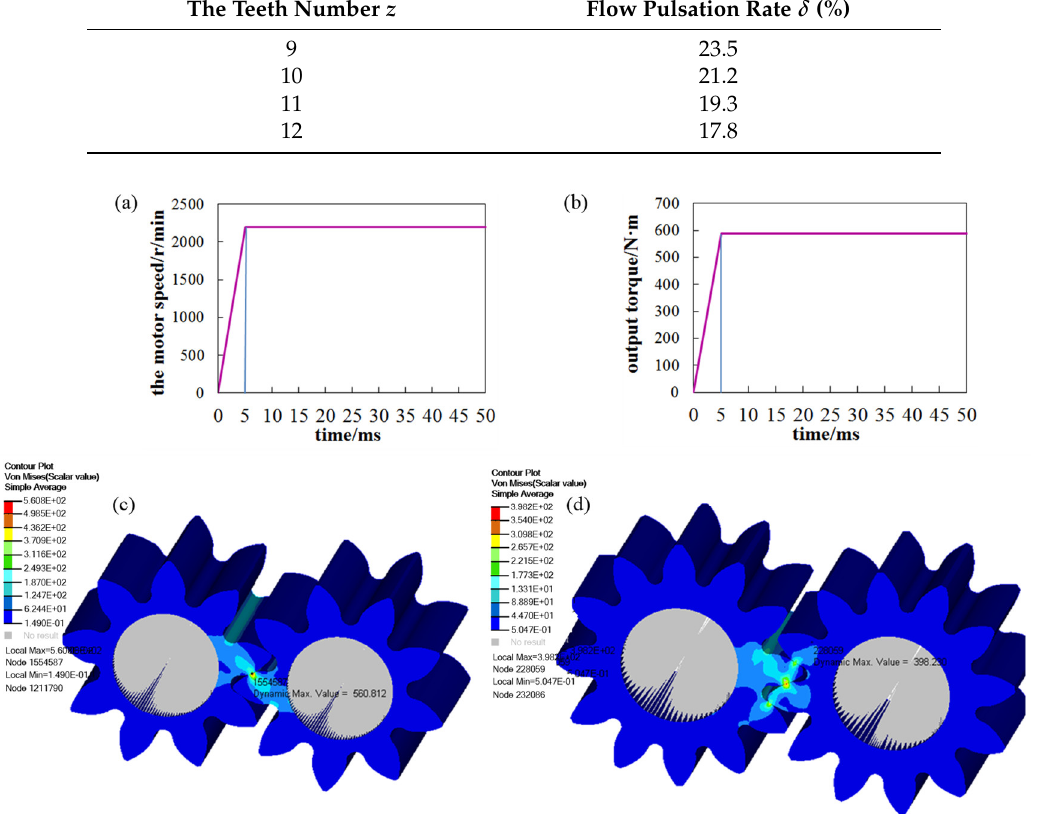
Figure 10. The meshing forces of the gear pump.